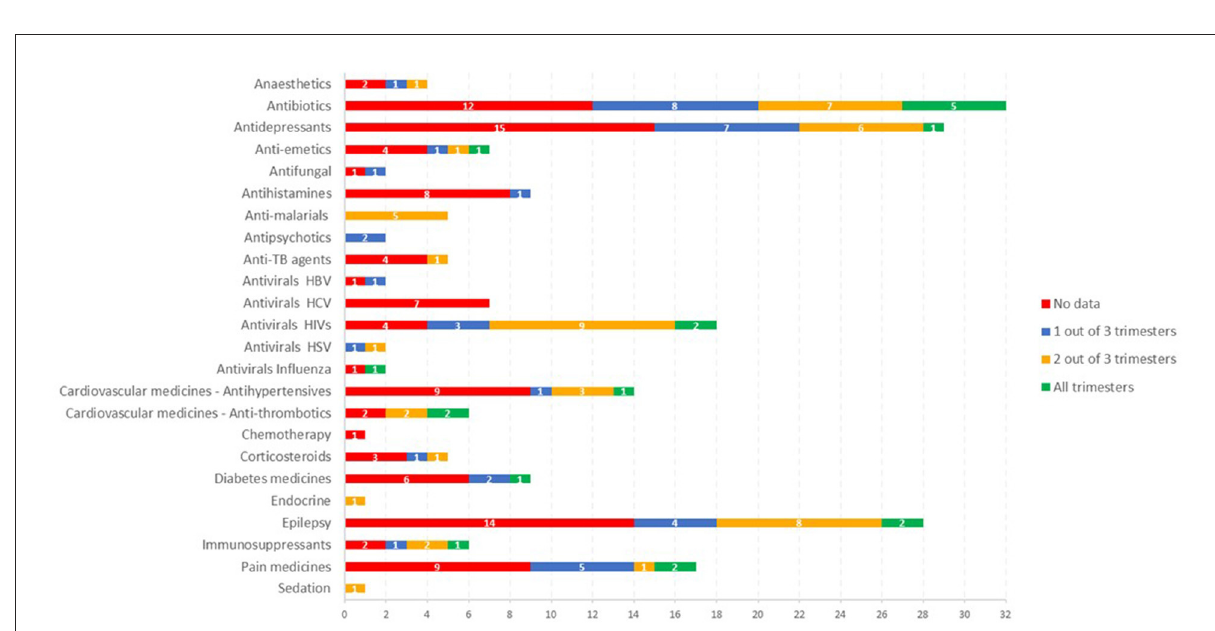
FIGURE2 The availability of published PK data in pregnancy grouped by the investigated therapeutic